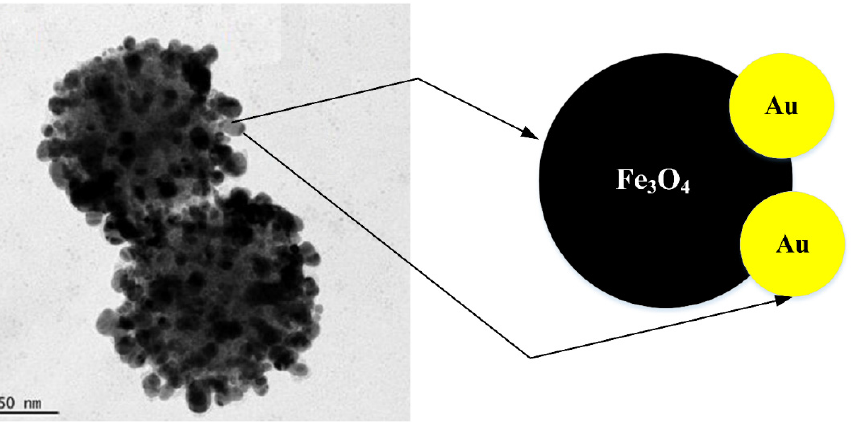
Figure 4. TEM image [55] and schematic drawing of Fe 3 O 4 @Au DNPs dumbbell